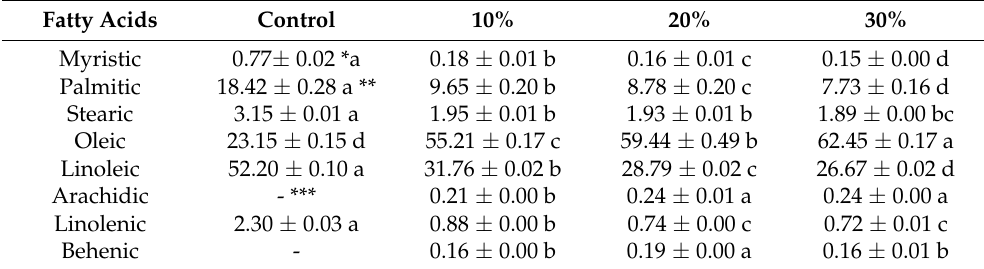
Table 3. Fatty acid compositions of bread samples with coriander seed powder (%). Fatty Acids